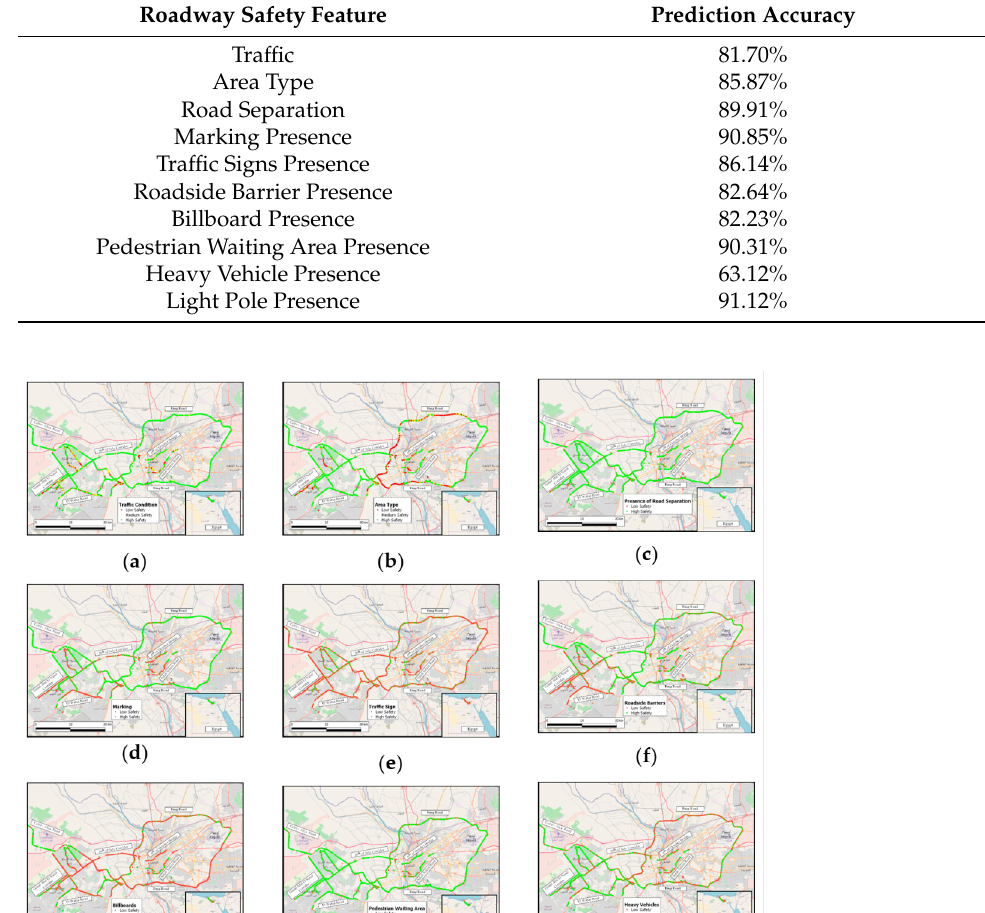
Table 6. Roadway safety features estimation accuracy.